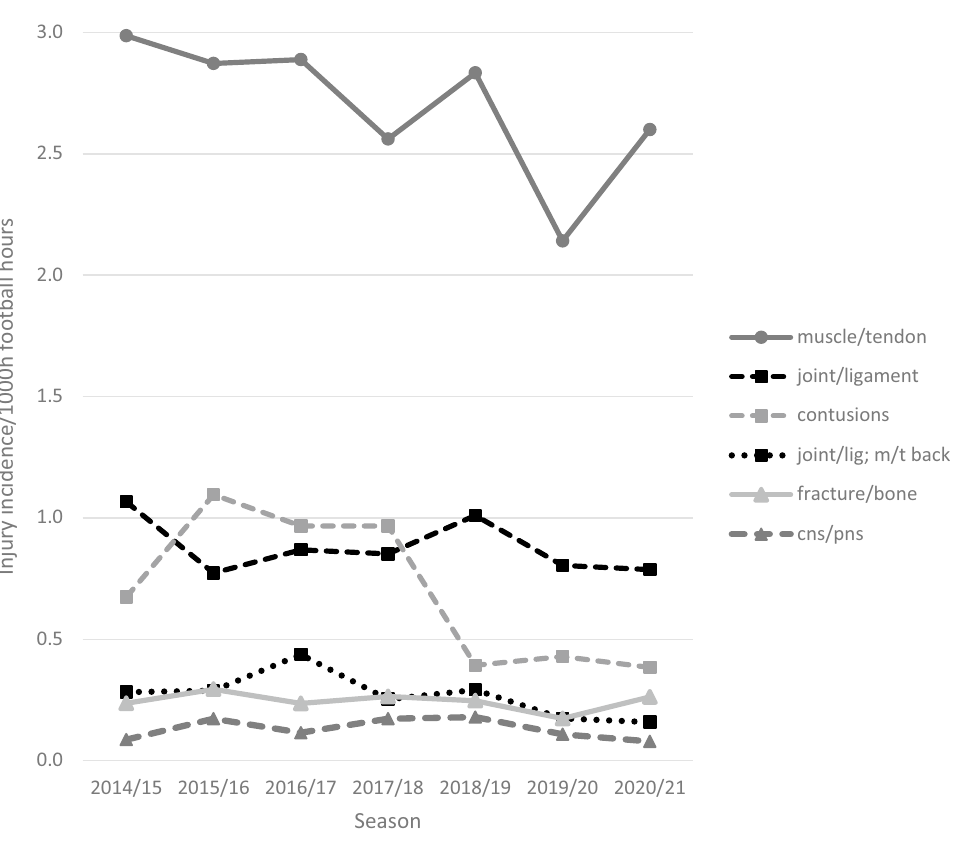
Fig. 2 Time trends—injury incidence rates per 1000 football hours according to injury types. Lig ligament, M/t muscle/tendon, CNS/PNS central/ peripheral nervous system